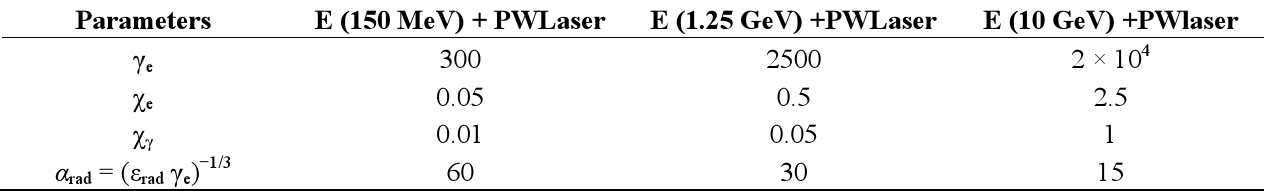
Table 1. Peak values of the invariants χ interacting with electron beams of different energy (150 MeV, 1.25 GeV, and 10 GeV). a is the normalized laser field at which the radiation friction effects come into